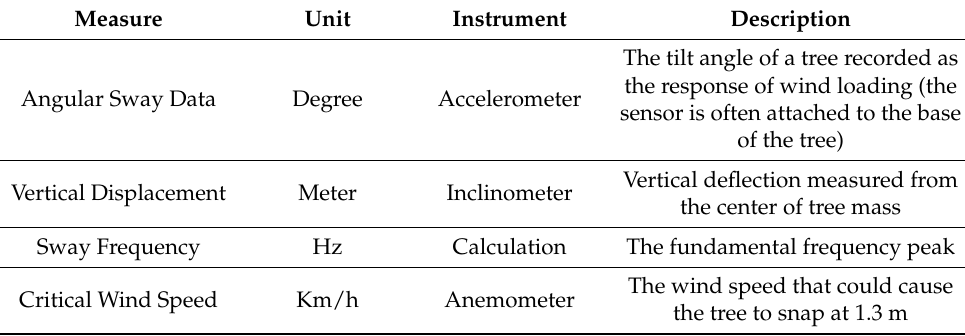
Table 1. Existing measures for tree tilt analysis. Measure Unit